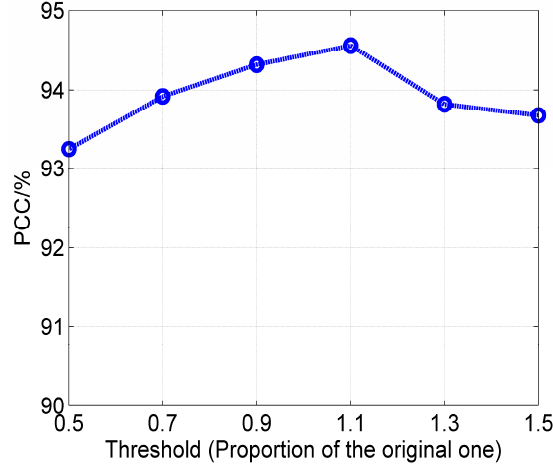
Figure 11. The average PCCs of the proposed method at different thresholds for shadow segmentation.